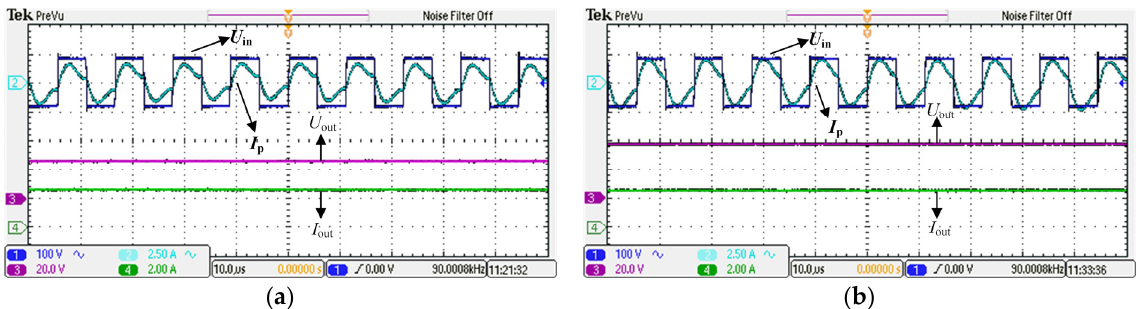
Figure 13. Experimental waveforms of the IPT system in CC charging mode. ( a ) R L = 10 Ω ; ( b ) R L = 15 Ω .